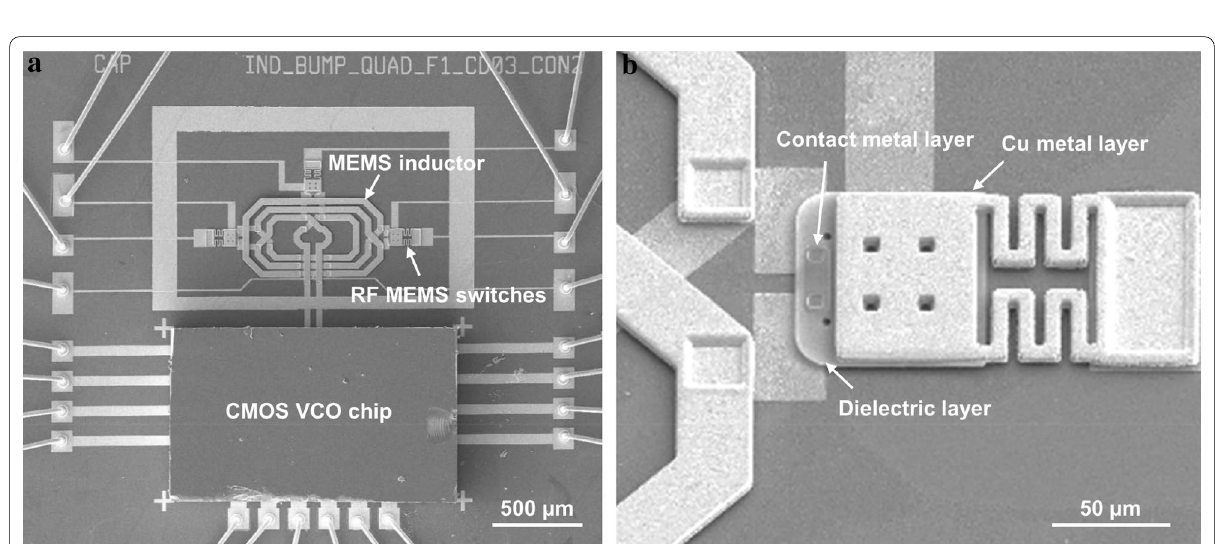
Fig. 4 Scanning electron microscopy (SEM) images of the fabricated CMOS VCO integrated with the MEMS tunable inductor. a A SEM image of the fabricated inductor with CMOS VCO chip and pads. b A close‑in image of the electrostatic RF MEMS switch and signal lines connected to MEMS